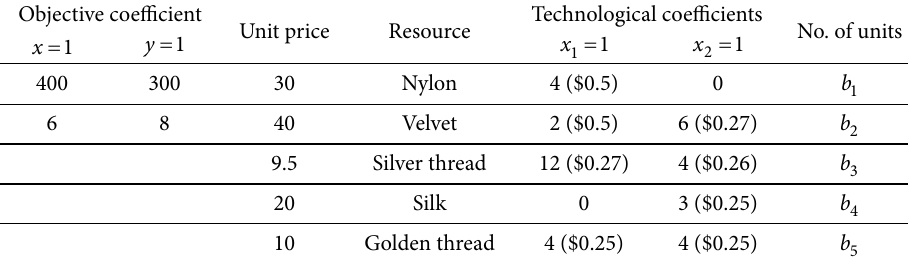
Table 5. Information table for Example